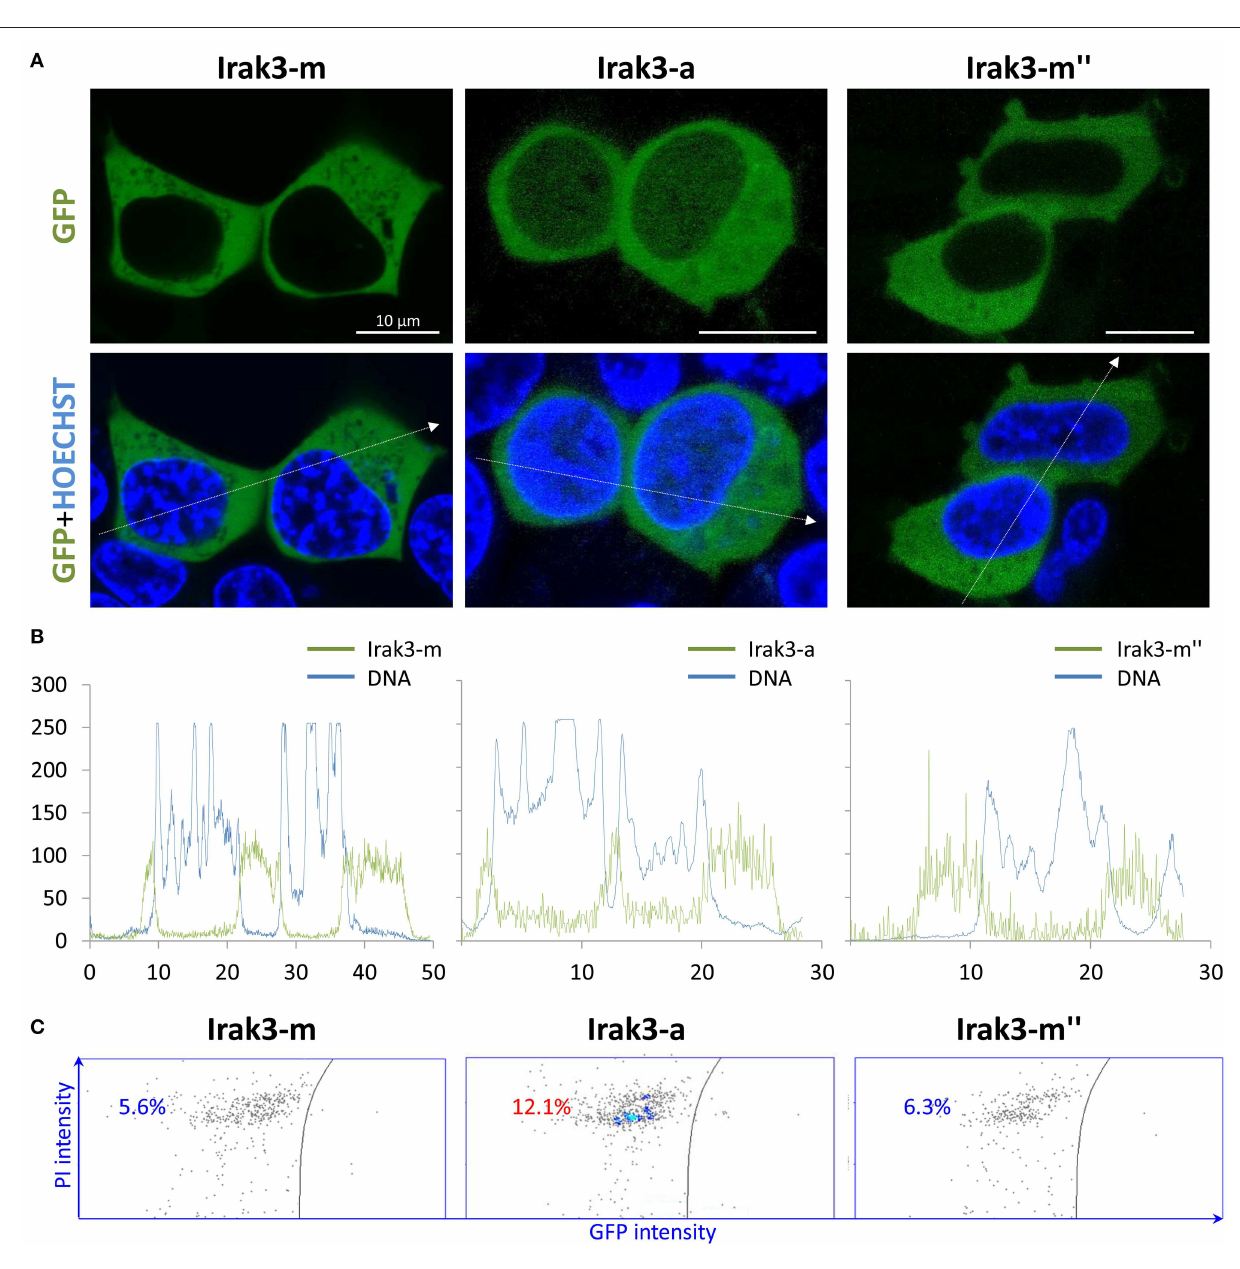
FIGURE 5 | Overexpression of full-length factor Irak3m and variants a, and m ′′ in HEK-293 cells. (A) Human HEK-293 cells were transfected with plasmids expressing the GFP-tagged Irak3 variants, the full-length factor m, truncated factor a, and splice variant m ′′ . Cells were visualized 24h after transfection with a confocal laser-scanning microscope. Nuclei were stained with Hoechst 33342 (blue). Scale bars represent 10 µ m in all images. (B) Profile of fluorescence intensities (ordinate) recorded at specific locations (abscissa) across the cell following that path as indicated by the dotted arrows in 4A. (C) Live/dead assay of HEK-293 cells quantified the proportion of dead cells in the total cell count after the overexpression of full-length Irak3-m, truncated Irak3-a or spliced Irak3-m ′′ factors. The left part of each of the three dot plots shows the number of dead (PI-stained) GFP-negative cells and the right part shows the number of living GFP-positive ( irak3 -expressing) cells. One representative result is